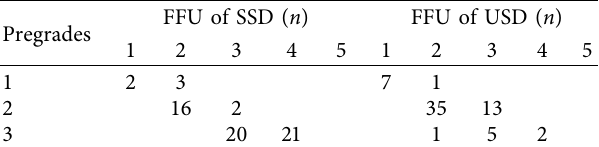
Table 4: Lumbar disc degeneration observed on MRIs by the Pfirrmann grading